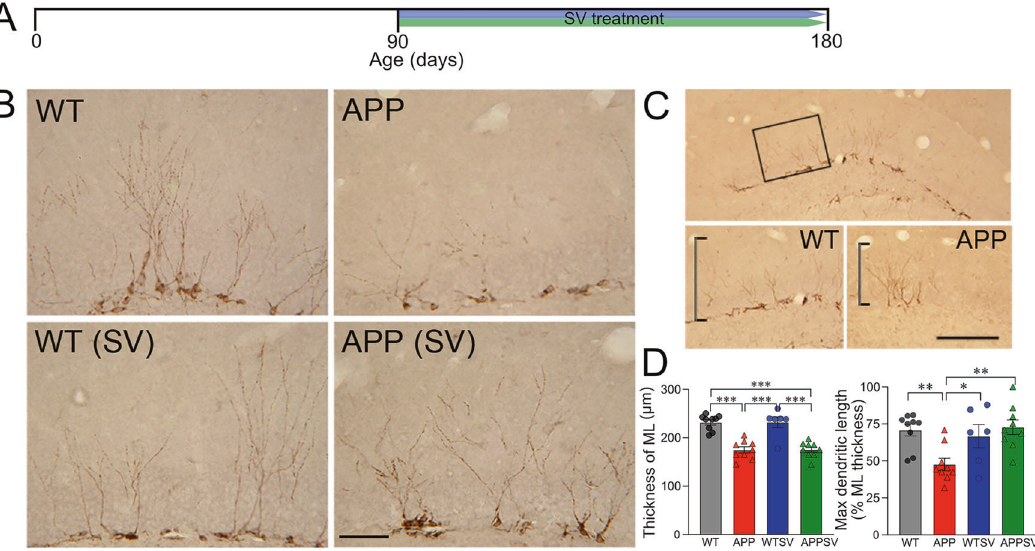
Fig. 2 SV normalized dendritic outgrowth of DCX immature neurons in APP mice. A Schematic representation of experimental design and timeline of SV treatment. B DCX-positive immature neurons were visualized by DAB immunohistochemistry in the DG of WT, APP, and WT and APP mice treated with SV (WTSV and APPSV). C The black box in the top panel indicates the target area for measuring the thickness of the molecular layer (ML) of the DG. The ML in APP mice was statistically thinner than that of WT mice, and there was no difference between treated and untreated animals ( D left panel). After correcting for the reduced thickness of the ML, the maximum length of DCX- immunostained dendritic extensions was shorter in APP mice compared to WT ( D right panel), a de fi cit that was fully corrected by SV treatment that promoted extension of the DCX dendrites in treated APP mice to levels comparable to WT ( D right panel). Scale bars = 200 µm. * p < 0.05, ** p < 0.01, and *** p < 0.001, using two-way ANOVA followed by Newman – Keuls post-hoc SV-treated APP mice in the number of Ki67 and DCX cells in all age groups (Fig. 1D).